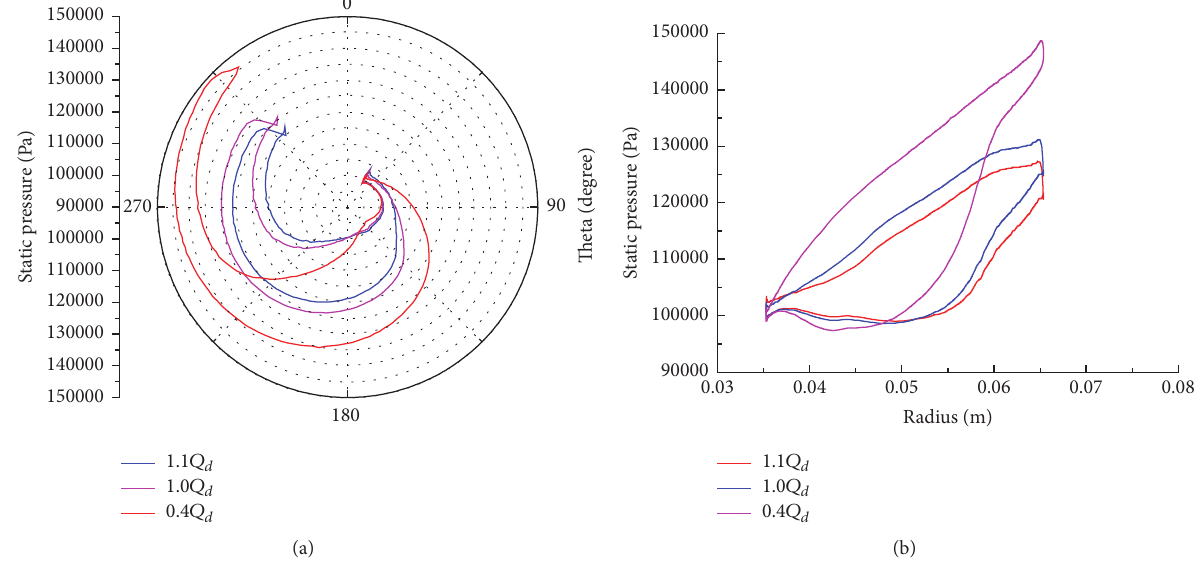
Figure 13: Comparison of static pressure distributions on the blades in the theta direction (a) and the blade radial direction (b) at the flow rates of 1.1 𝑄 𝑑 and 1.0 𝑄 𝑑 and 0.4 𝑄 𝑑